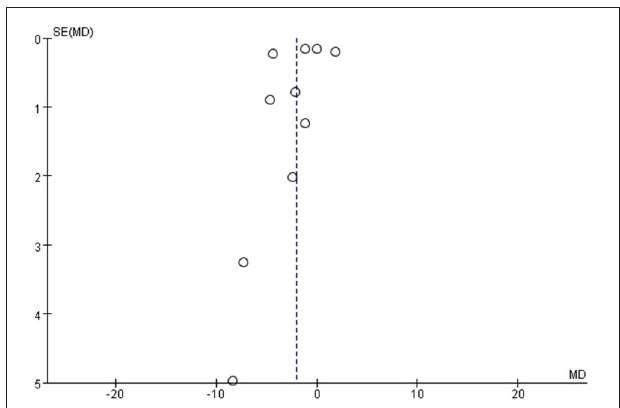
FIGURE 6 | Funnel plot for the diastolic blood pressure (DBP). Funnel plot with pseudo 95% confidence